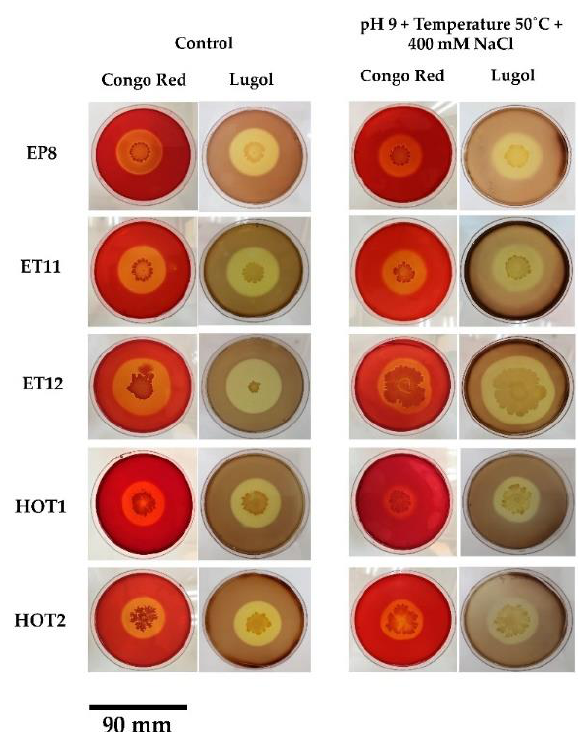
Figure 14. Illustration of the CMC hydrolysis zone by the strains tested in the presence of triple stress revealed by Congo red and Lugol solutions.